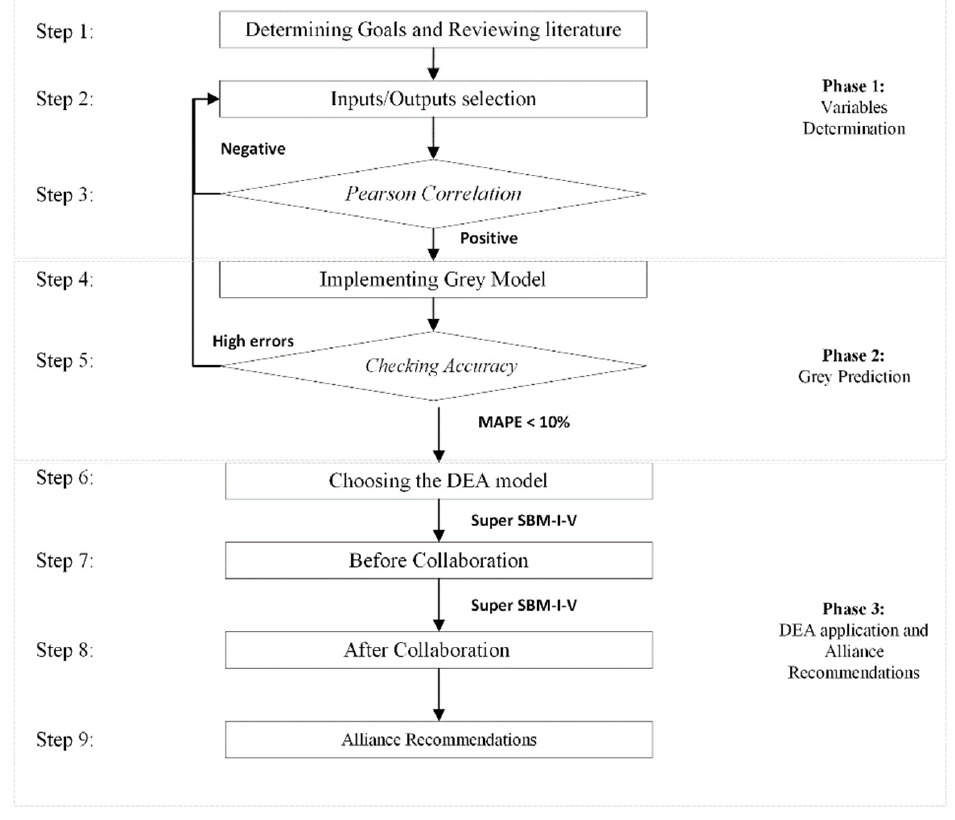
Figure 1. Research development.